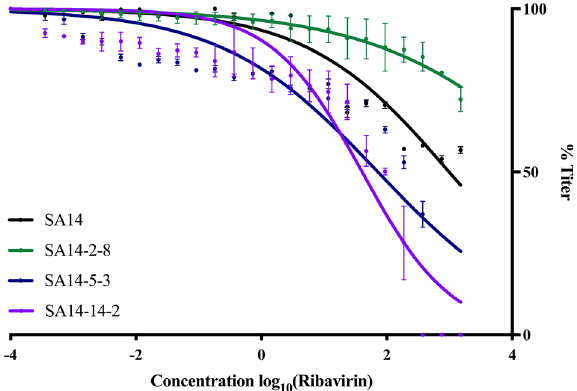
Fig. 6 Dose response of WT JEV and JEV vaccine strains to the antiviral ribavirin. SA14, SA14-14-2, SA14-5-3 and SA14-2-8 were incubated with the GTP nucleoside analog, ribavirin. After 48 h, the supernatant was collected and titrated for viral load (FFU). Titers at each concentration were normalized to untreated, infected cells and fi t using a dose-response linear regression. The experiment was undertaken in triplicate and points shown are an average of these experiments. A four-parameter, non-linear regression was used to fi t sensitivity curves (SA14 R 2 = 0.89, SA14-14-2 R 2 = 0.89, SA14-5-3 R 2 = 0.79, SA14-2-8 R 2 = viremia in SA14-2-8 infected mice were signi fi cantly higher at 3 dpi than for SA14-14-2 ( p = 0.0002)(Table 2). In contrast, at the time of euthanasia, viral titers in the brain of SA14-2-8 infected mice were signi fi cantly lower than in SA14-14-2 animals ( p =